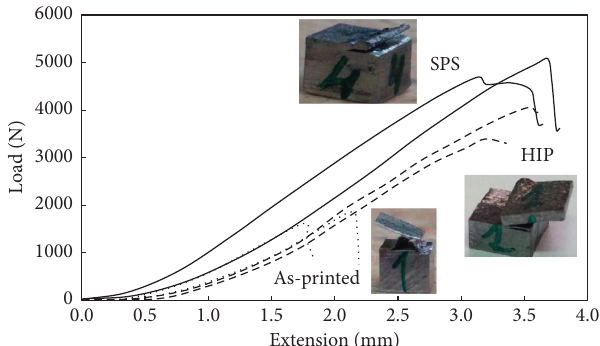
Figure 12: Shear test load/displacement curves and specimens after shear testing (adopted from [21]).